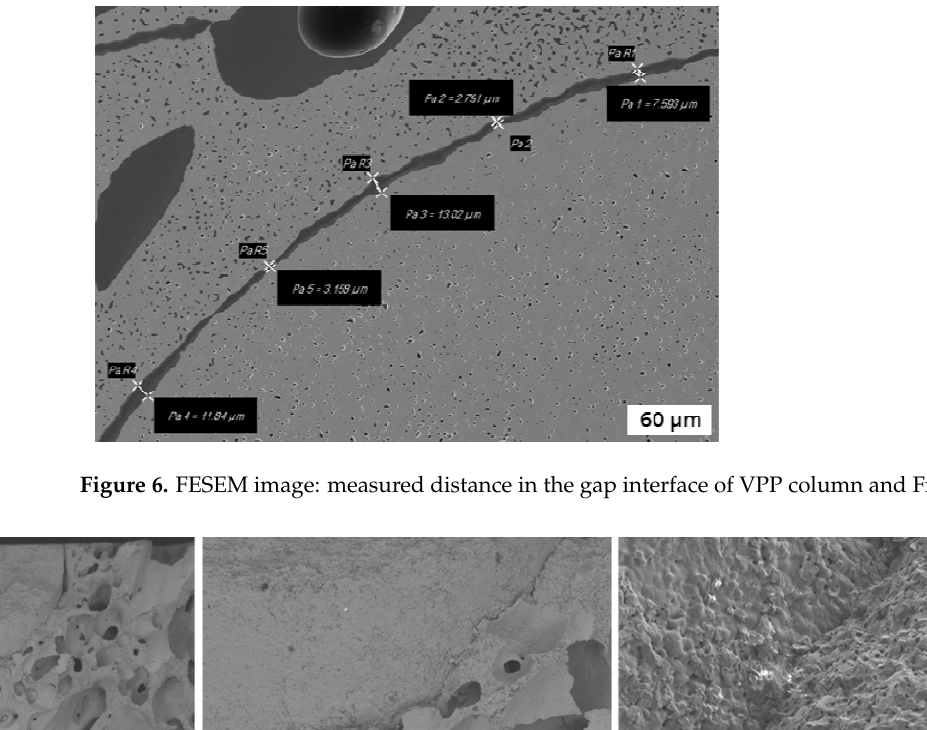
Figure 6. FESEM image: measured distance in the gap interface of VPP column and Freeze Foam.